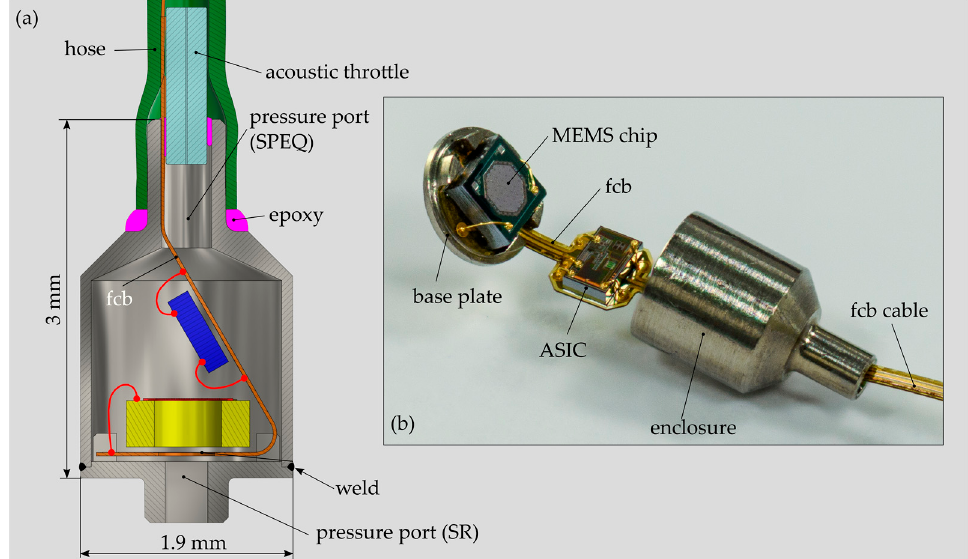
Figure 10. ( a ) Computer-aided-design (CAD) drawing of the MEMS condenser microphone (MEMS CMIC) installed in customized Ti housing. The drawing shows the non-planar arrangement of the MEMS chip and ASIC that allows a housing geometry with an optimal form-factor to be used for ICAR insertion into the inner ear (adapted from Reference [15]) and ( b ) the assembled flexural circuit board (FCB) before installation of the microphone enclosure.